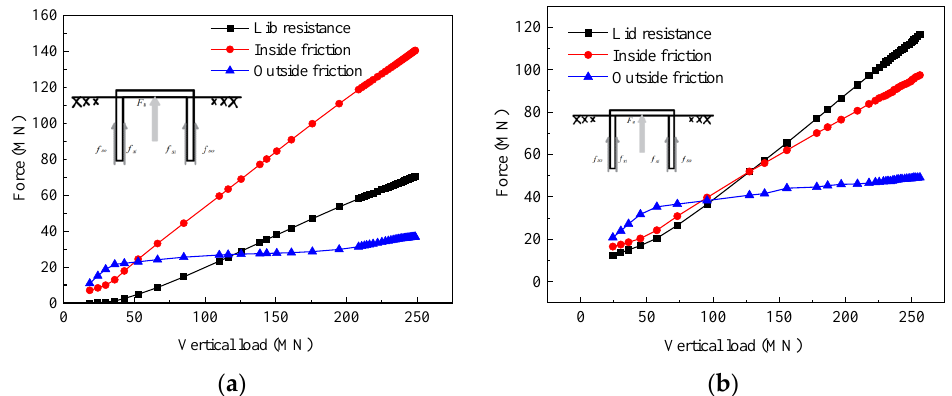
Figure 7. Resistance provided by each part of the foundations at different vertical loads. ( a ) TSPJF, ( b ) TBJF.